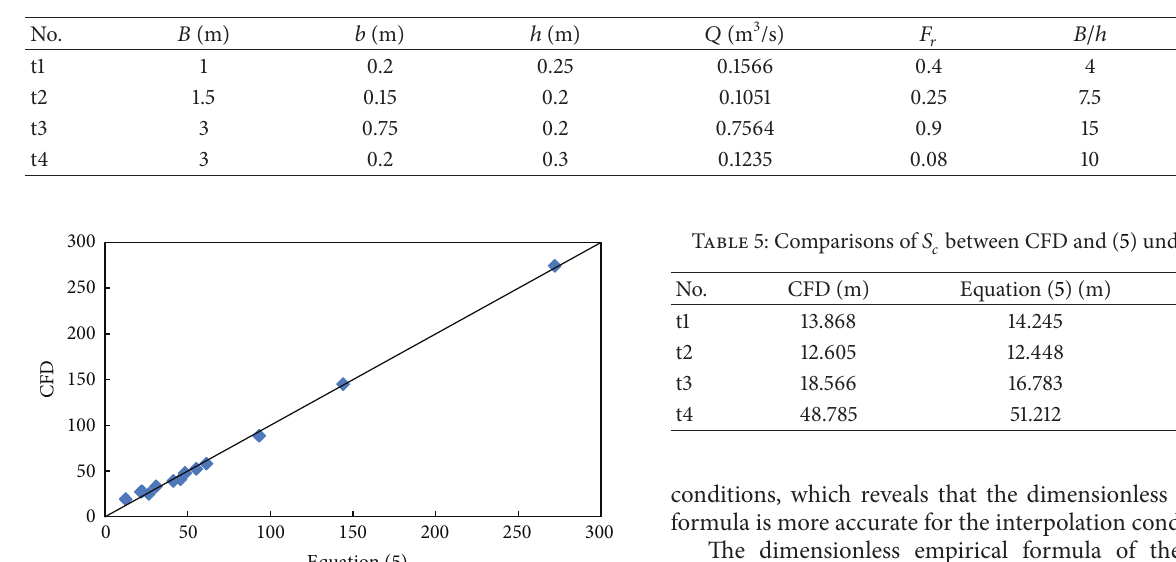
Table 4: Testing conditions.